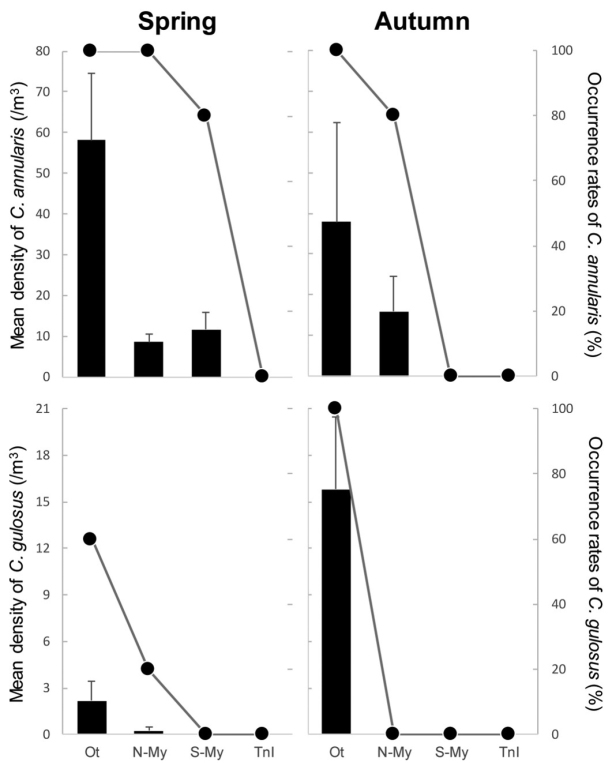
Results of quantitative samplings in rockpools at four sites on the eastern coast of Kyushu, southern Japan. Solid bars and plots show mean density (error bars indicating standard error) and occurrence rates of each species of Chaenogobius (upper, C.
annularis; lower, C.
gulosus) at each site in the two seasons (left, spring; right, autumn) respectively. Abbreviations of the sites on the x-axis are as follows: Ot, Oita; N-My, N-Miyazaki, S-My, S-Miyazaki; TnI, Tanega-shima (these locality names correspond to those used in Fig. 3). Sample sizes, n = 5, except for Tanega-shima in autumn (n = 8).